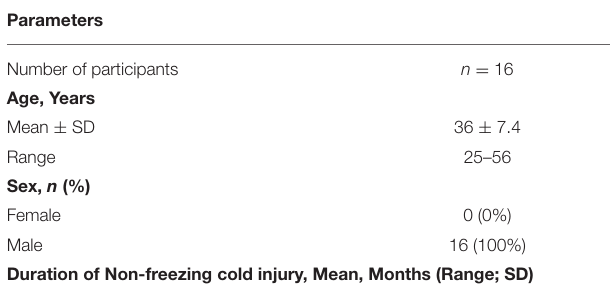
TABLE 1 | Participant demographics and